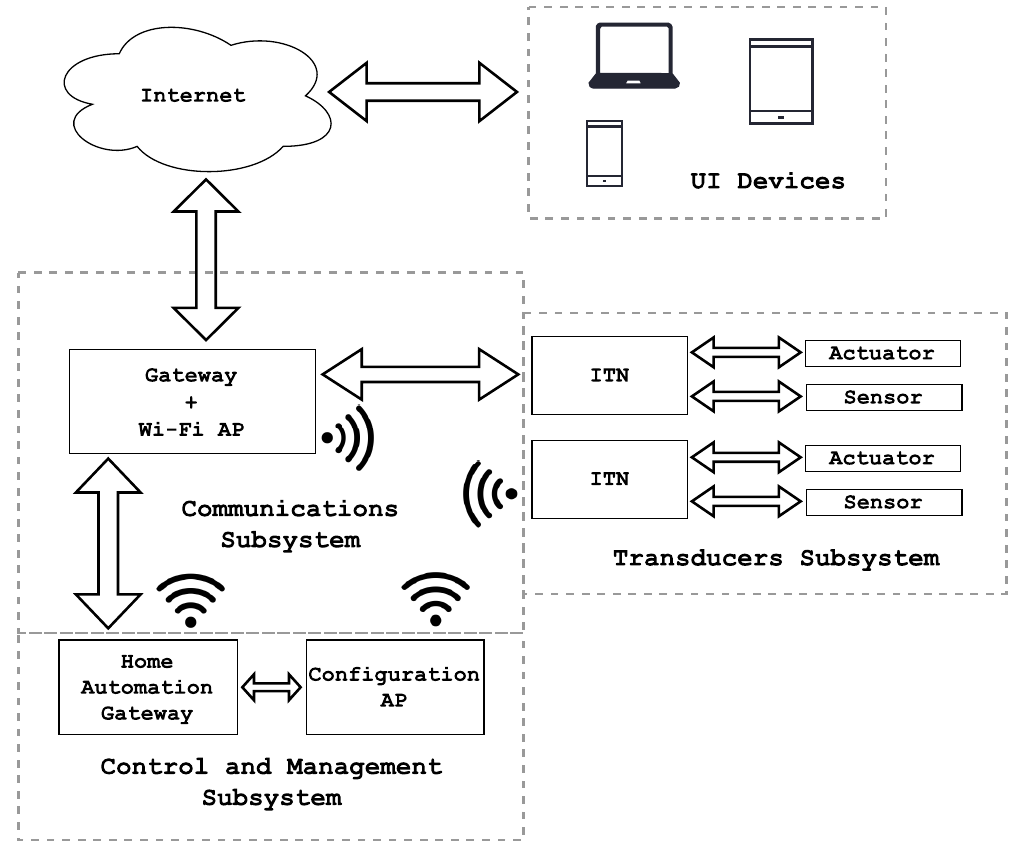
Figure 2. HASITE’s